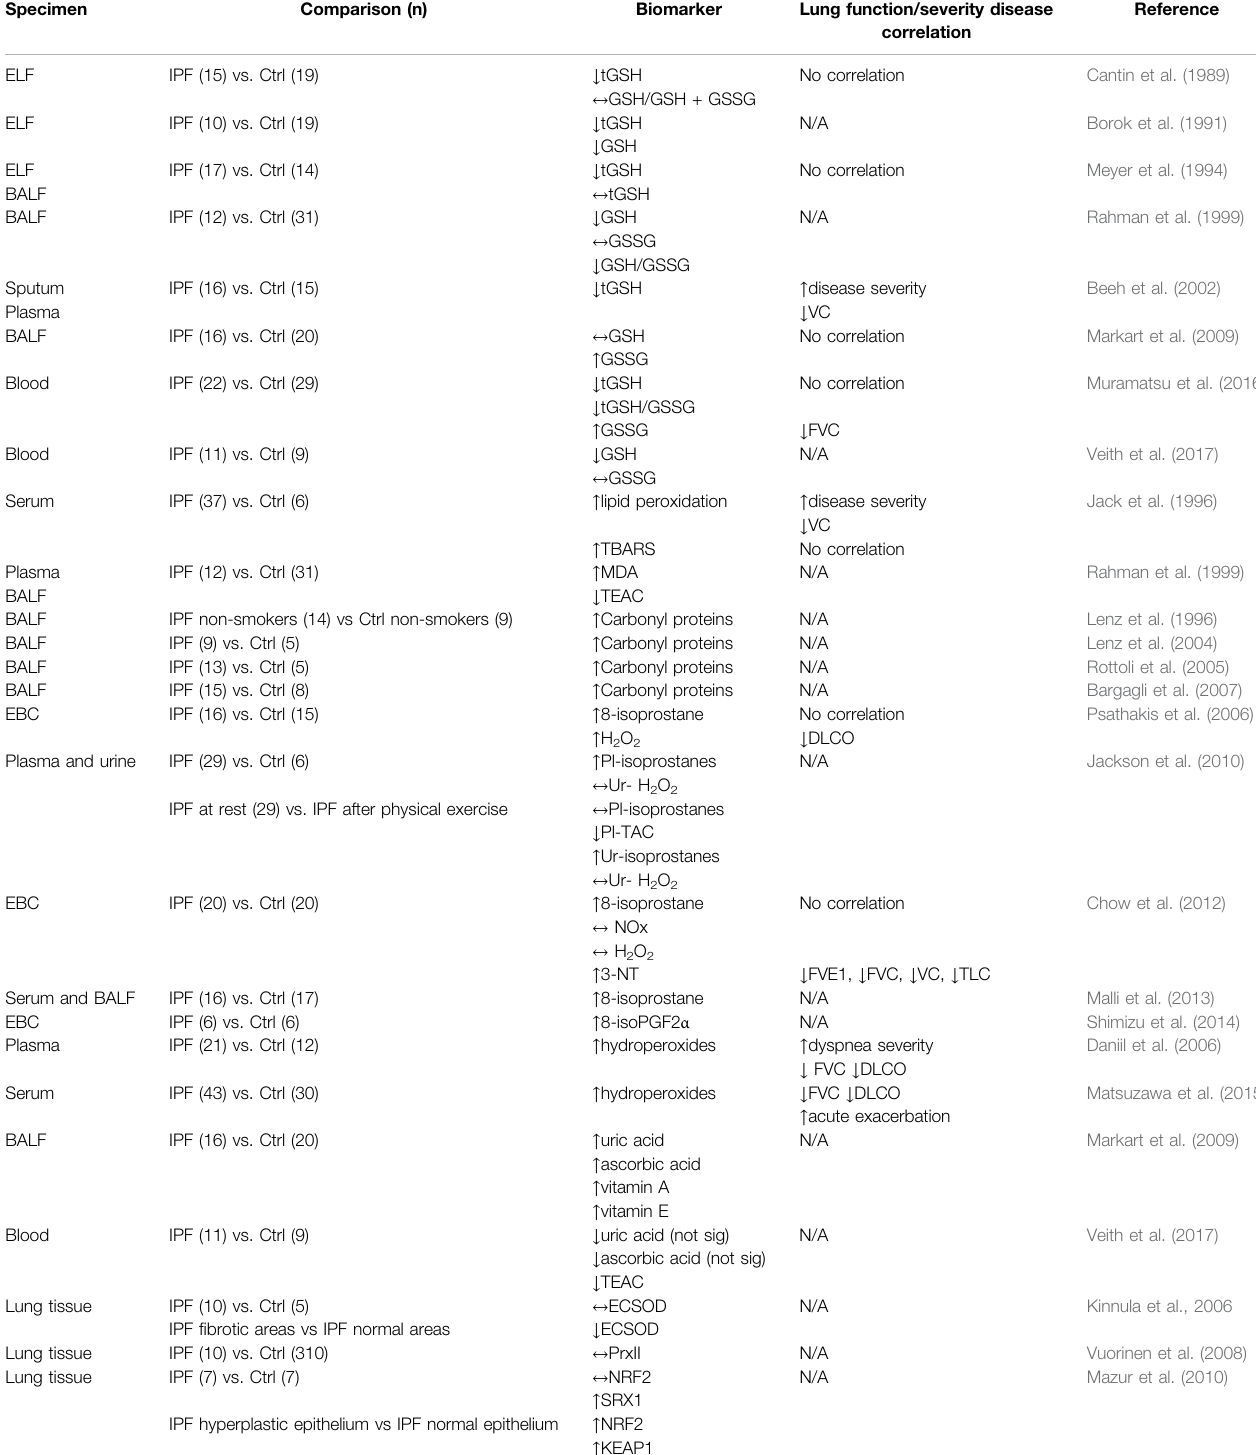
TABLE 2 | Summary of the oxidative stress biomarkers analysed in different biological specimens of IPF